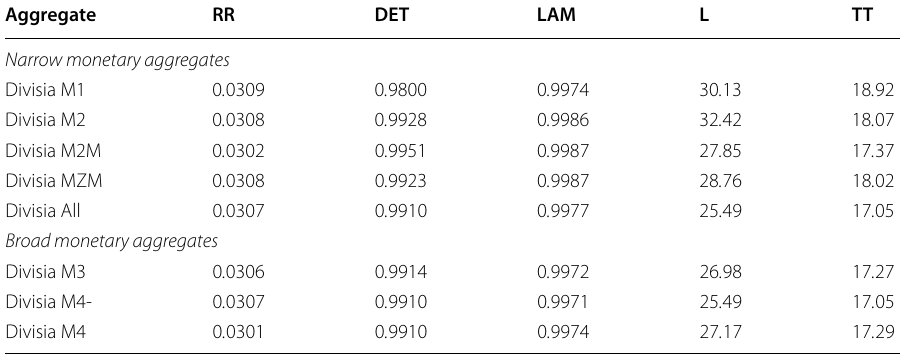
Table 5 RQA of Divisia aggregates (in growth rates) Aggregate RR DET LAM L TT Narrow monetary aggregates Divisia M1 0.03171 0.1858 0.3763 Divisia M2 0.0323 0.1897 Divisia M2M 0.0316 Divisia MZM 0.0306 0.1894 3.120 Divisia All 0.0319 0.1739 0.3373 2.165 2.357 Broad monetary aggregates Divisia M3 0.0323 0.2580 Divisia M4- 0.0307 Divisia